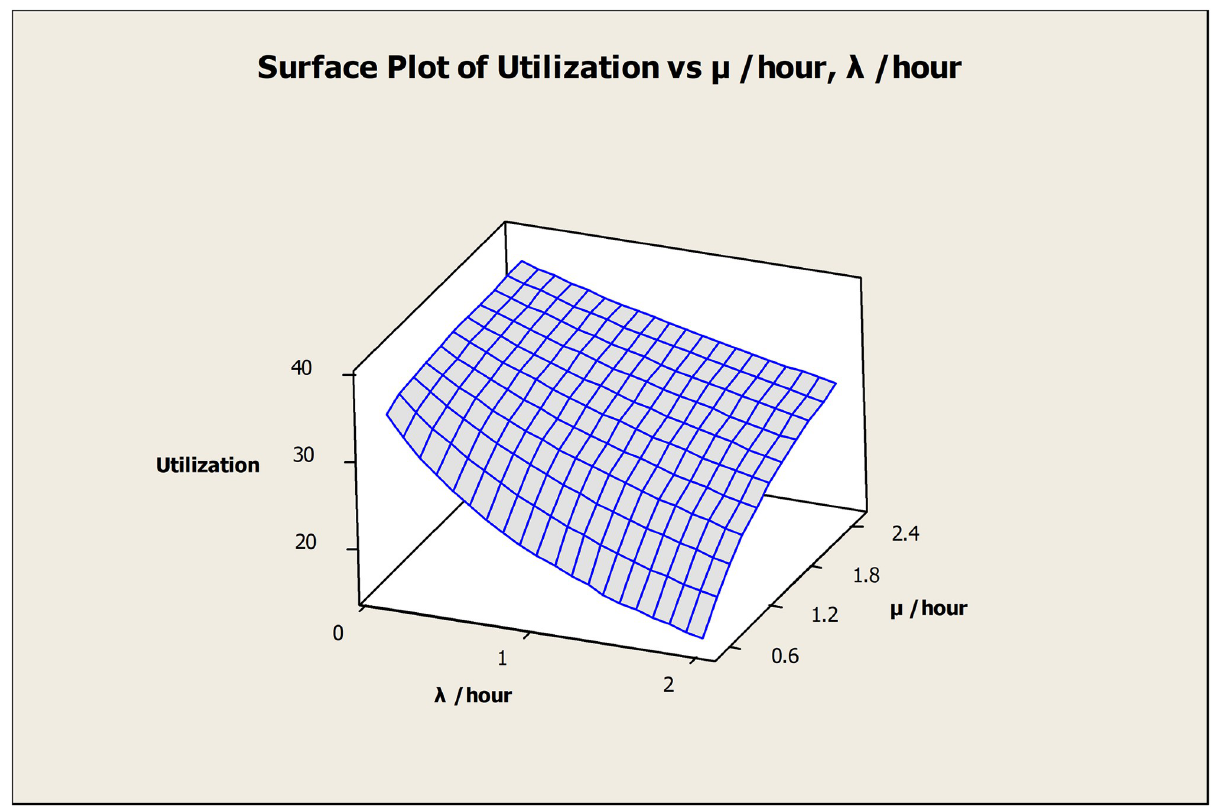
Fig 8. Surface plot of utilization vs μ /hour, λ